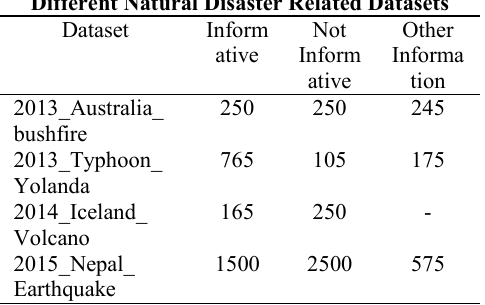
Table 2. Datasets used in the proposed system Different Natural Disaster Related Datasets